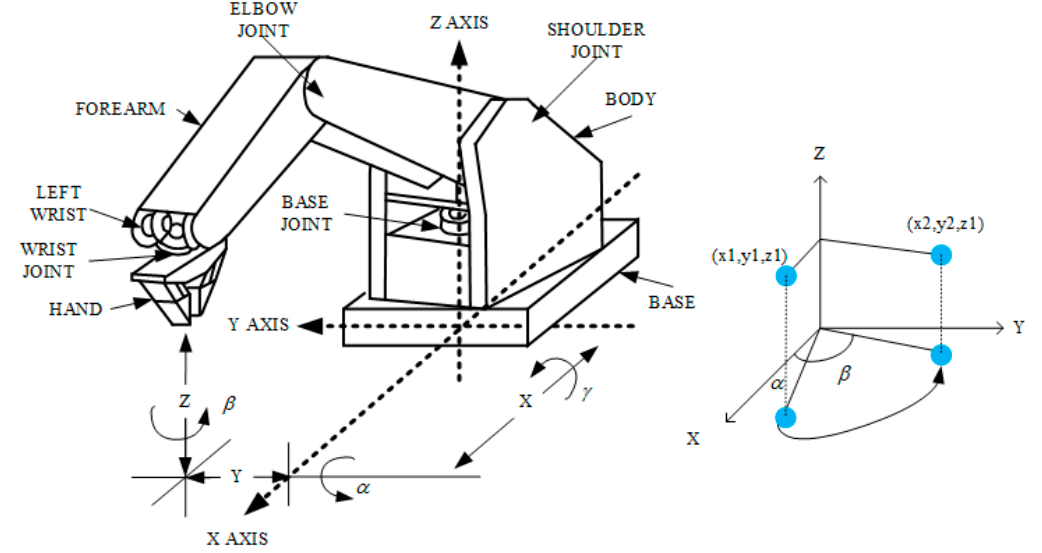
Figure 3. The five-axis robotic arm and degree of freedom of the control coordinate system.